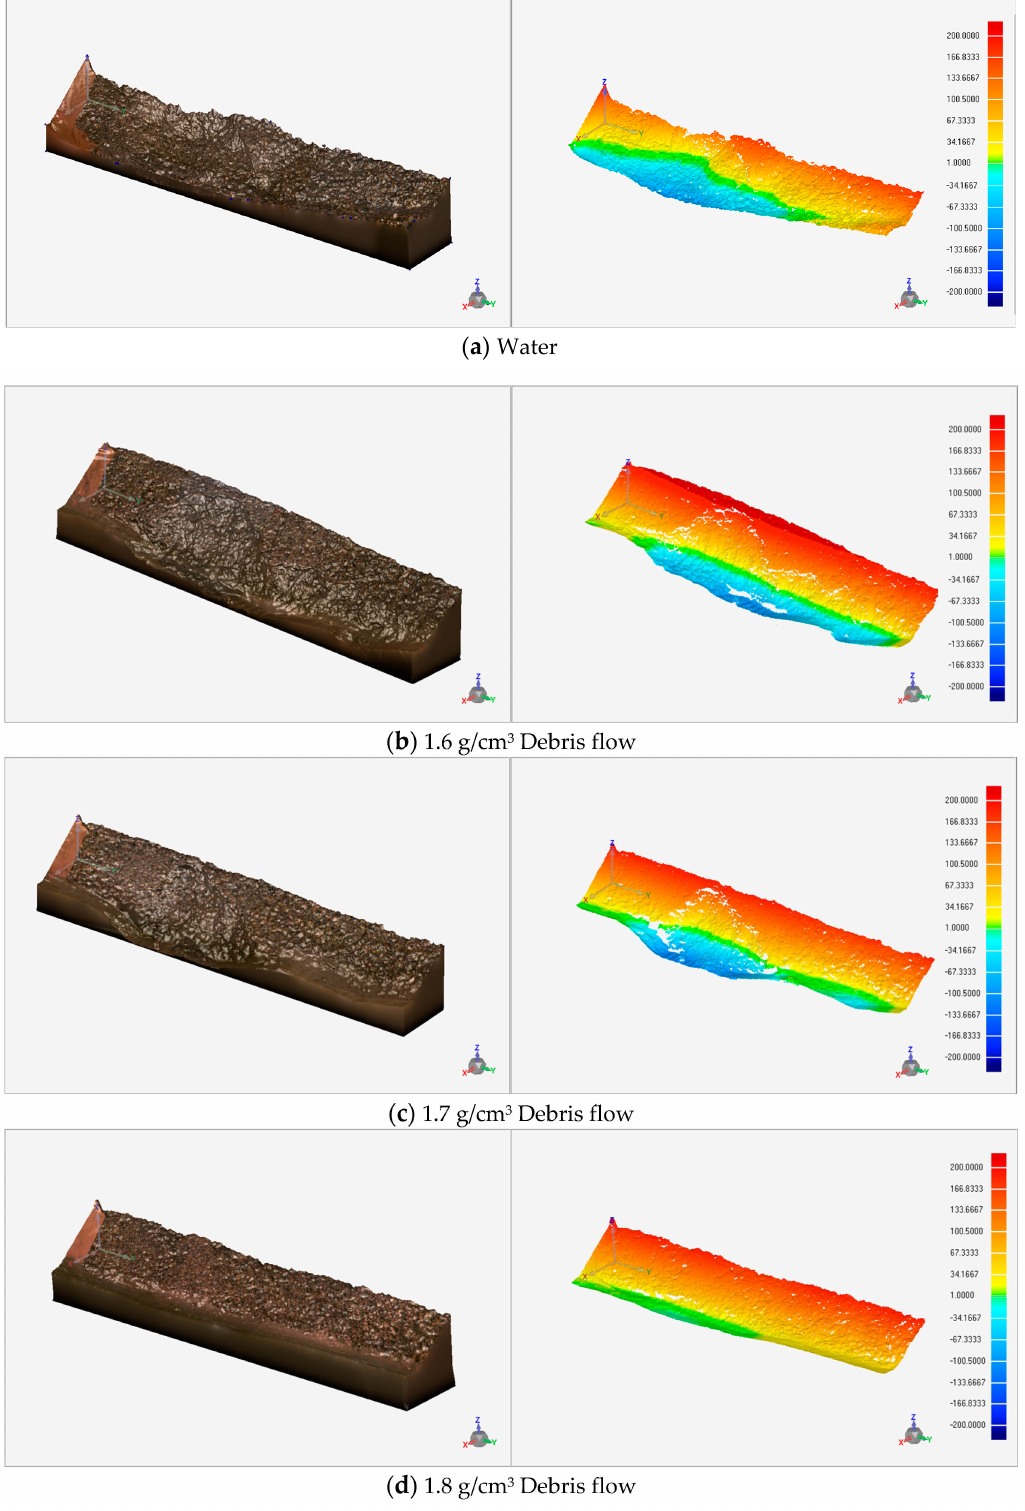
Figure 2. Comparison diagram of debris flow erosion with different unit